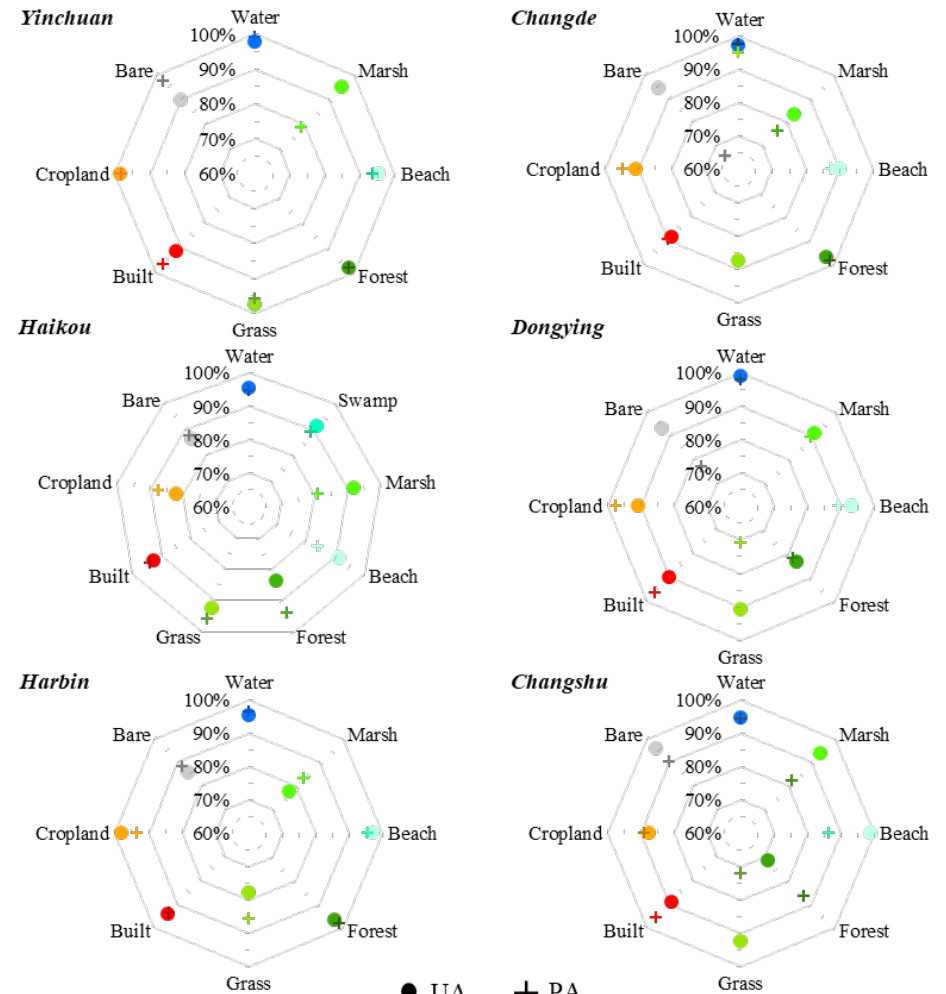
Figure 3. Producer’s accuracy (PA) and user’s accuracy (UA) for land cover types in 6 cities in 2015.